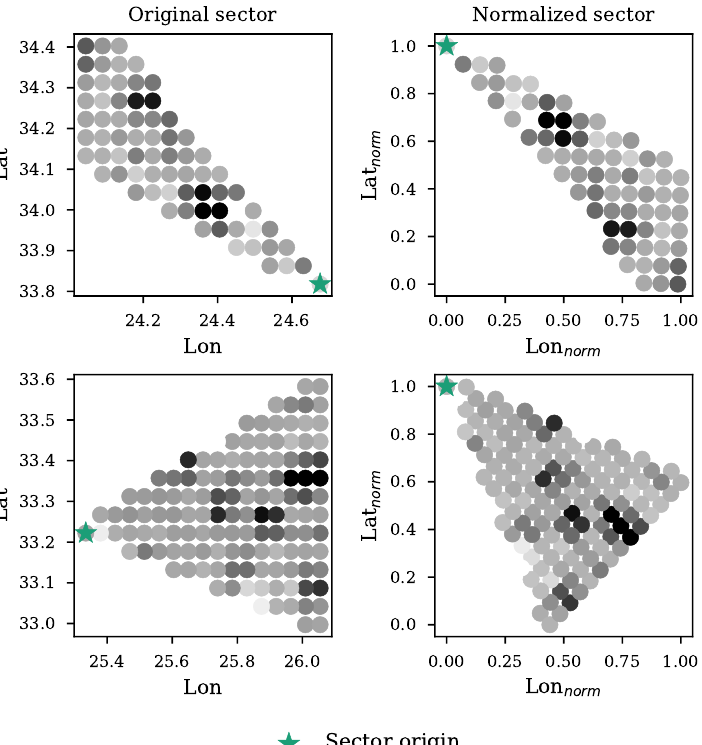
Figure 6. Sector normalization. We rotate the ship sectors so that all resulting sectors have the same orientation equal to 320 ◦ , independently of the original direction of the ship’s heading. We then rescaled the image so that the range of both coordinates is between 0 and 1. The gray area in each figure indicates a ship sector . The ship sector origin indicator shows the position of the ship at the moment of the satellite overpass. Two examples of original and rotated sectors are shown: one in the top row and one in the bottom row.